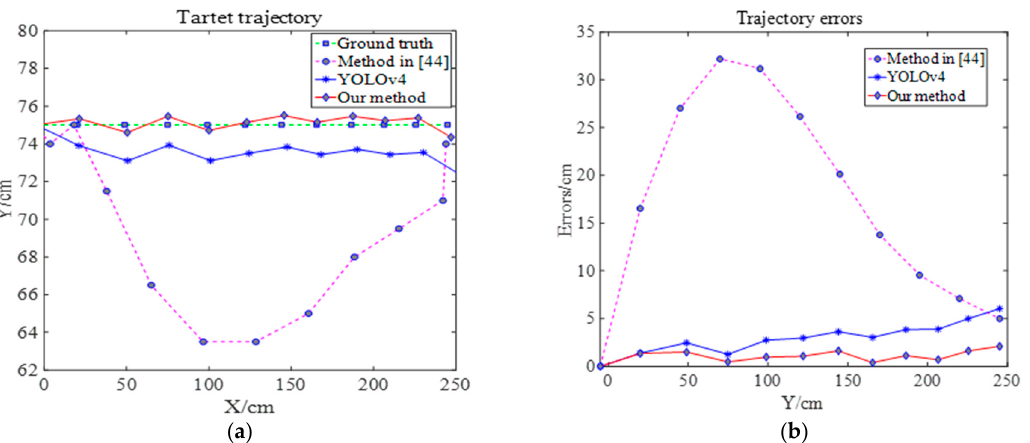
Figure 15. Trajectory and trajectory error of the target on the vertical channel. ( a ) Target trajectory. ( b ) Trajectory errors [44].